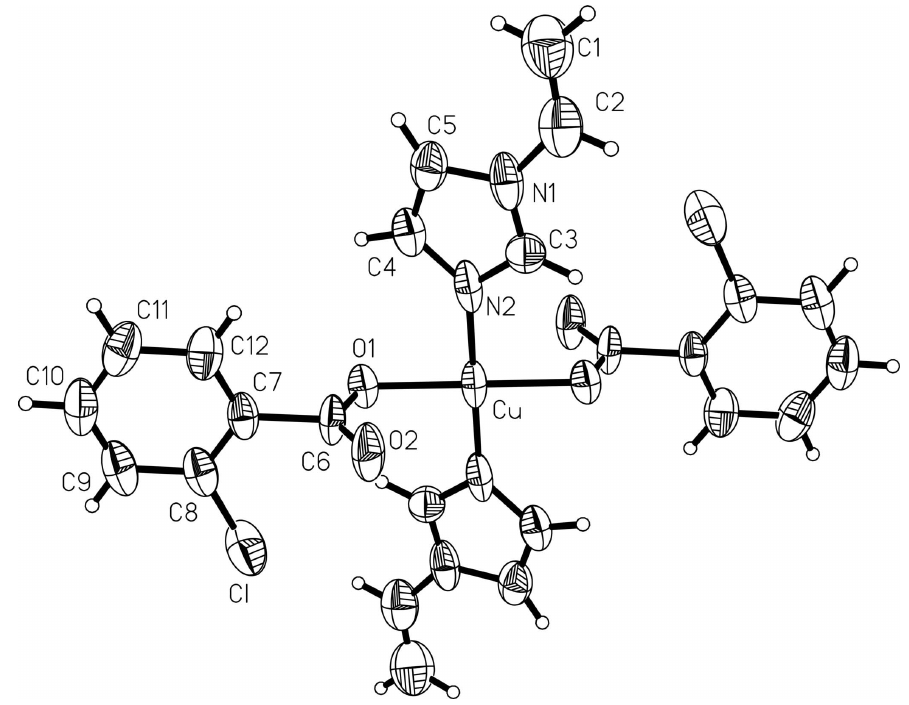
Figure 1 The molecular structure of (I), showing 50% probability displacement ellipsoids and the atom-numbering scheme. The unlabelled atoms are related with the labelled ones by symmetry operation (- x , - y , - z